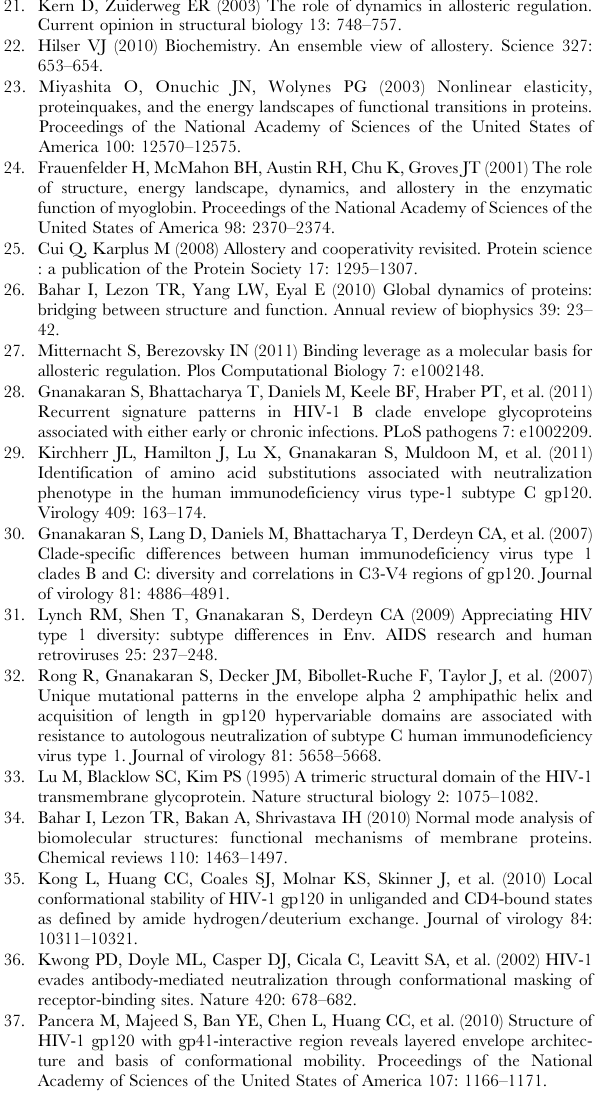
Table S2 Hotspots in YU2, HXB2, and CAP210 networks. Table S3 The hot spot residues in each network that occur at the interface (within 4.5 Angstroms of antibody) of antibody binding sites are listed. The residue number shown in the table refers to the HXB2 sequence numbering while the residue name corresponds to the strain of gp120 in the PDB structure. Table S4 Binding Leverage of hot spot residues identified using community analysis from YU2 simulation. The binding leverage of a residue refers to the highest binding leverage of a site in which the hotspot residue is present. Table S5 Binding Leverage of hotspot residues identified using community analysis from CAP210 simulation. The binding leverage of a residue refers to the highest binding leverage of a site in which the hotspot residue is present.